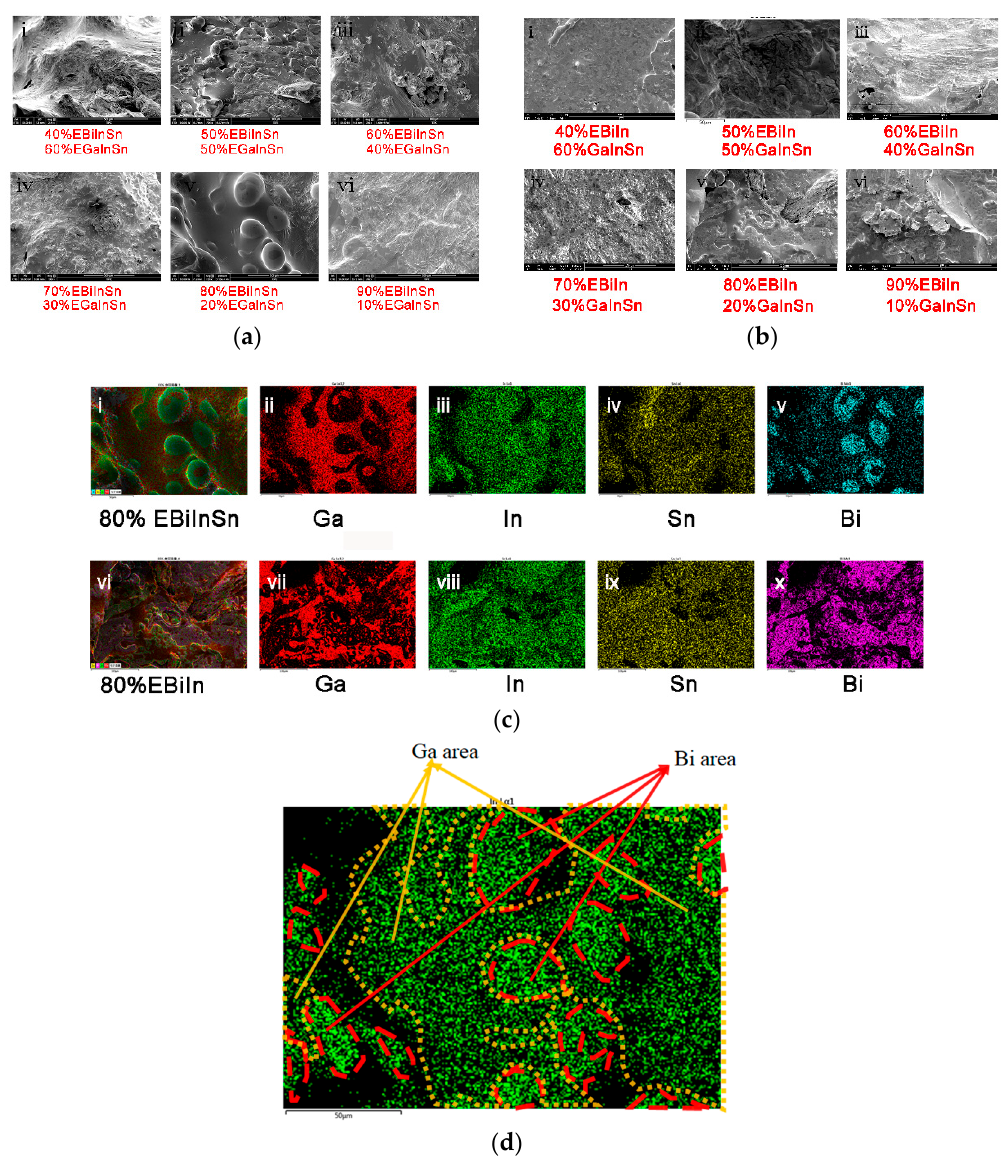
Figure 3. ( a ) SEM graphics of EBiInSn-based alloy mixtures. ( b ) SEM graphics of EBiIn-based alloy mixtures. ( c ) Energy spectrum diagram of 80% Bi-based alloy mixtures. The element gallium and bismuth were intermingled with each other, filling the entire space. ( d ) Distribution map of In in 80% EBiInSn. The area in red dashes and the yellow dashes represent the area of Bi and Ga, respectively. To identify the specific ingredients of the mixtures, we performed DSC tests on all